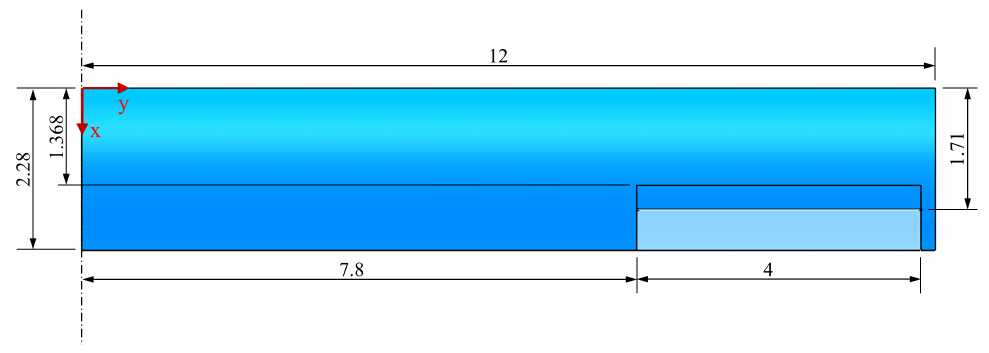
Figure 1. The right half-wing configuration equipped with the hinged aileron.